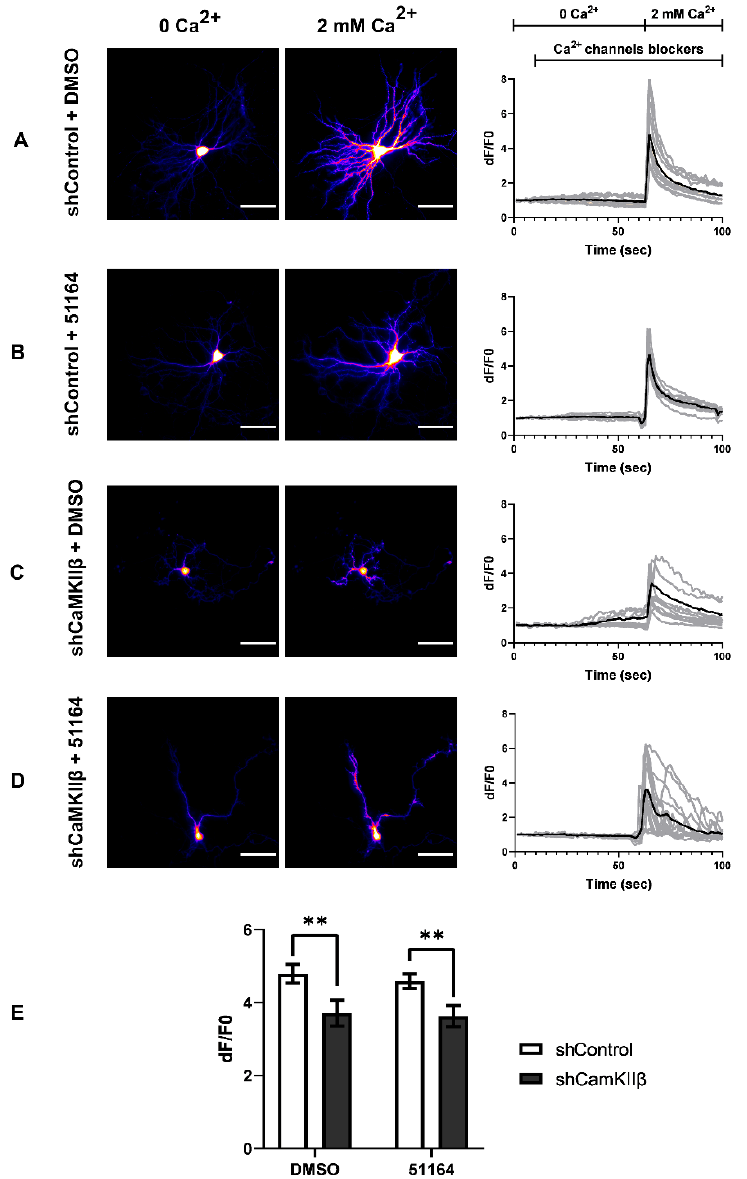
Figure 1. 51164 does not rescue a decrease in hippocampal postsynaptic nSOCE amplitude in conditions of CaMKII β knockdown. ( A – D ) Representative images of primary hippocampal neurons in the absence (0Ca 2+ ) or presence (2 mM Ca 2+ ) of Ca 2+ and time courses of GCaMP5.3 relative fluores- cence signal changes (F/F0) in the individual dendritic spines. The presence of Ca 2+ channel blockers (Tg, TTX, Nifedipine, D-AP5, CNQX) and the time of extracellular Ca 2+ addition are indicated above the traces. Individual spine (gray) and average (black) fluorescence traces are shown for each exper- imental group. Neurons were co-transfected with either the shControl + GCamp5.3 (shControl) or shCaMKIIβ + GCamp5.3 (shCaMKIIβ) plasmids. Results are shown for the neurons that were incu- bated for 24 h with 100 nM of an equal volume of DMSO ( A , C ) or 51164 ( B , D ). 51164 (100 nM) was also added to the Ca2+ channel blocker solution during imaging ( B , D ). Scale bar = 100 µm. ( E ) Av- erage nSOCE spine peak amplitude was shown for each group of cells. The mean F/F0 peak ampli- tude signals for each group are presented as the mean ± SEM (n ≥ 100 spines from two independent experiments). Normal distribution was checked by the Shapiro – Wilk test. Statistical analysis was performed using the Kruskal – Wallis test following Dunn ’ s multiple comparisons test, ** p < 0.01. 3.2. 51164 Recovers Mushroom Spine Percentage in CaMKIIβ Knockdown Hippocampal Cul- tures